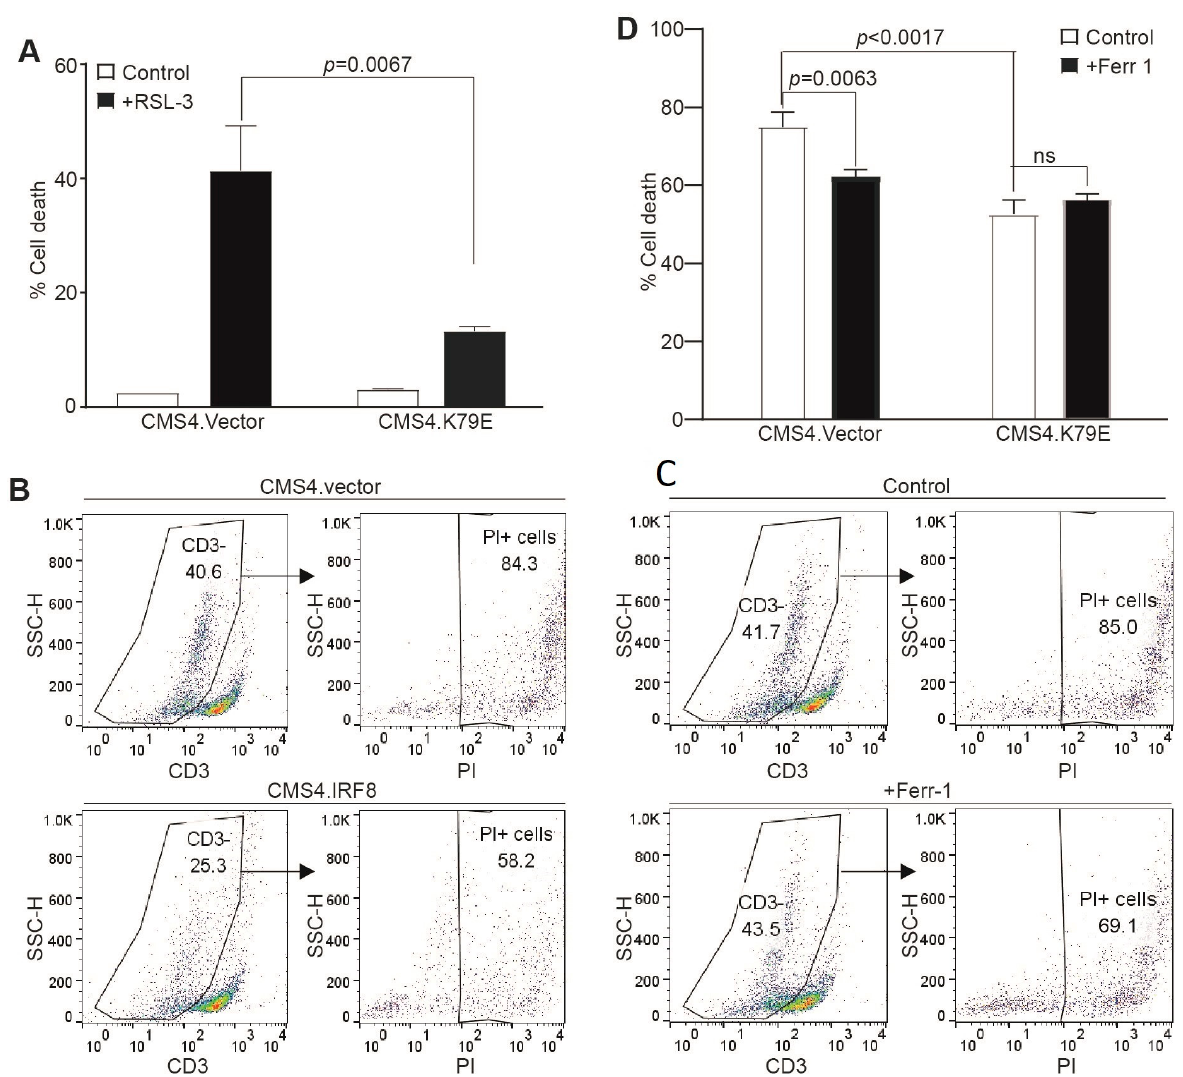
Figure 4. IRF8 regulates tumor cell sensitivity to ferroptosis and CTL lytic activity. ( A ) IRF8 WT vector control (CMS4.vector) and IRF8 mutant (CMS4.K79E) tumor cells were cultured in the presence of RSL-3 for approximately 24 h, stained with PI, and analyzed by flow cytometry to quantify cell death. ( B ) CMS4.vector and CMS4.K79E tumor cells were co-cultured with the tumor-specific CTLs at a 2:1 ratio for approximately 24 h. Cell mixture was collected, stained with CD3-specific monoclonal antibody and PI, and analyzed by flow cytometry. Shown are representative gating strategies. The CD3 − tumor cells were gated to quantify PI + tumor cells. ( C ) CMS4.vector tumor cells were co- cultured with the tumor-specific 220 CTL (2:1 ratio) in the absence (control) or presence of ferrostatin (Ferr-1 1 µ M) for approximately 24 h. Shown are representative gating strategies as in ( A , D ). The % cell death as shown in ( B , C ) was